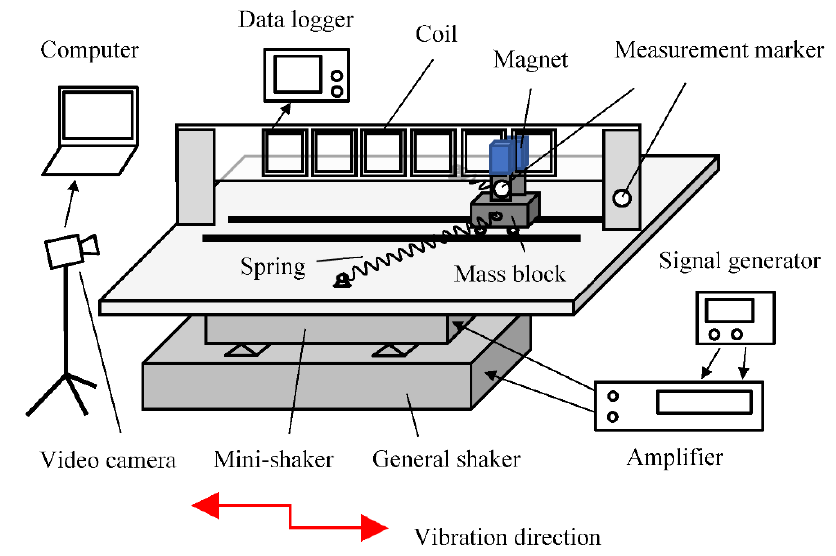
Figure 2. Measurement system for bi-stable vibration harvesting.